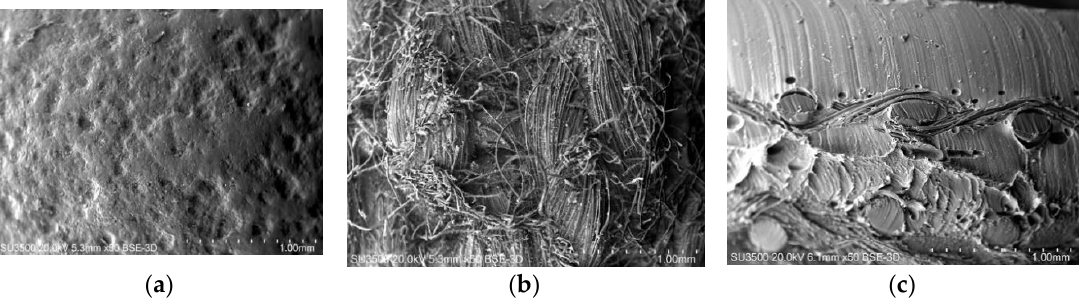
Figure 8. SEM images of: ( a ) topside of Flexam PVC surface; ( b ) bottom side of fabric surface; ( c ) cross- section of a reference sample.